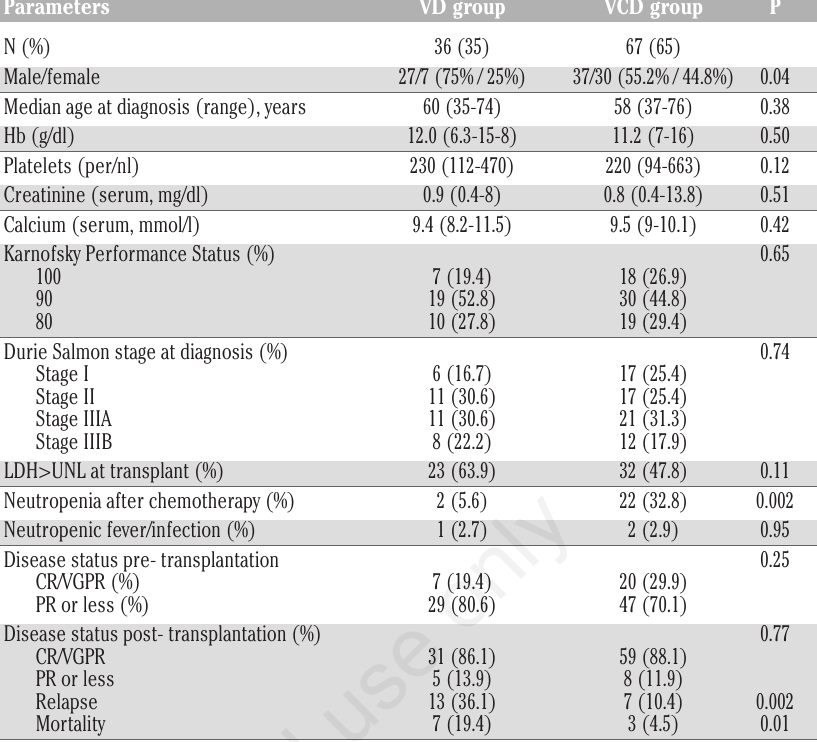
Table 1. Baseline clinical and demographic characteristics of patients.